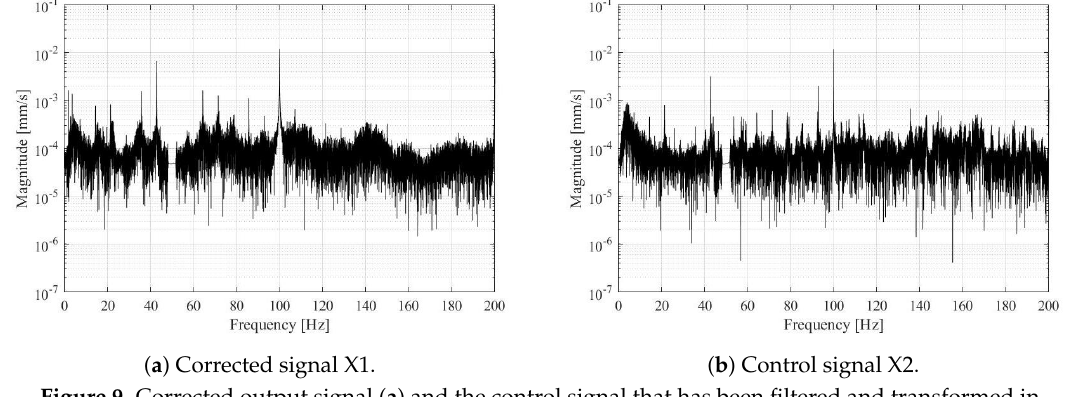
Figure 9. Corrected output signal ( a ) and the control signal that has been filtered and transformed in frequency spectrum ( b